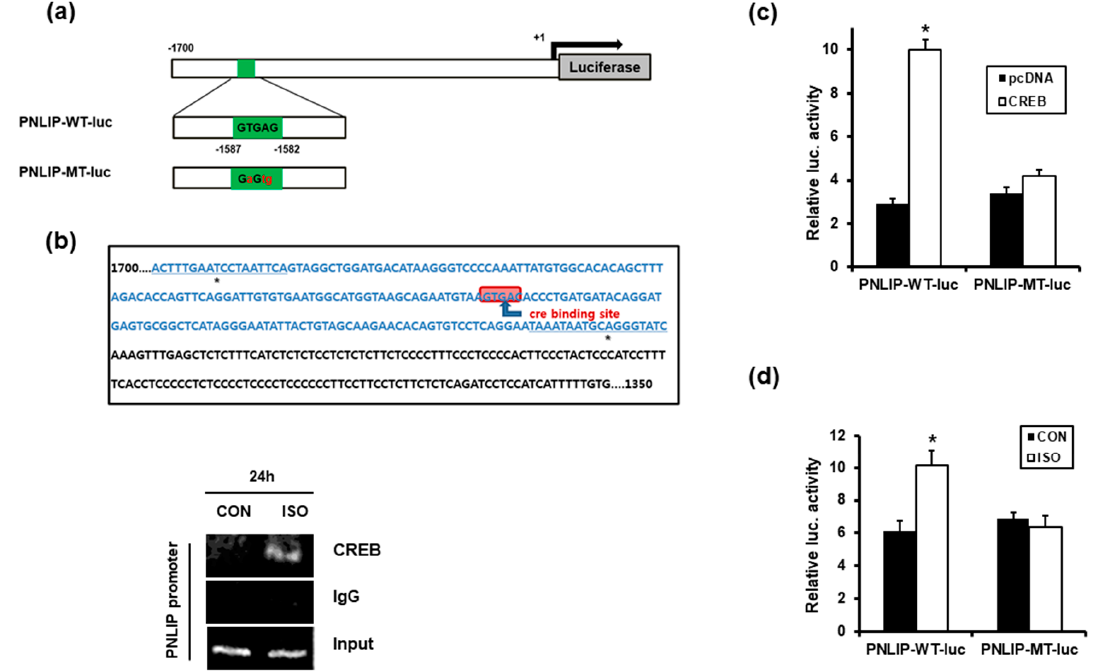
Figure 4. CREB bound to the PNLIP promoter and stimulated PNLIP transcription. ( a ) Schematic illustration of the luciferase (luc.) reporters containing the mouse PNLIP promoter. The highlighted bars show the nucleotide sequences of the putative CRE. ( b ) The 266-6 cells were treated with isoproterenol for 24 h, and the chromatin immunoprecipitation was performed with an antibody to CREB or with normal IgG (lower panel). The amplified DNA region in the PNLIP promoter DNA sequence is highlighted in blue (upper panel). ( c , d ) HEK 293 cells were transiently transfected with the indicated plasmids and incubated for 24 h ( c ), or the HEK 293 cells were transfected with the indicated PNLIP promoter reporter and incubated for 24 h in the presence or absence of isoproterenol ( d ). Then, luciferase activity was measured. The data are shown as the firefly luciferase activity relative to the Renilla luciferase activity and represent the means ± S.D ( N = 6). * p < 0.05 vs. pcDNA or CON.